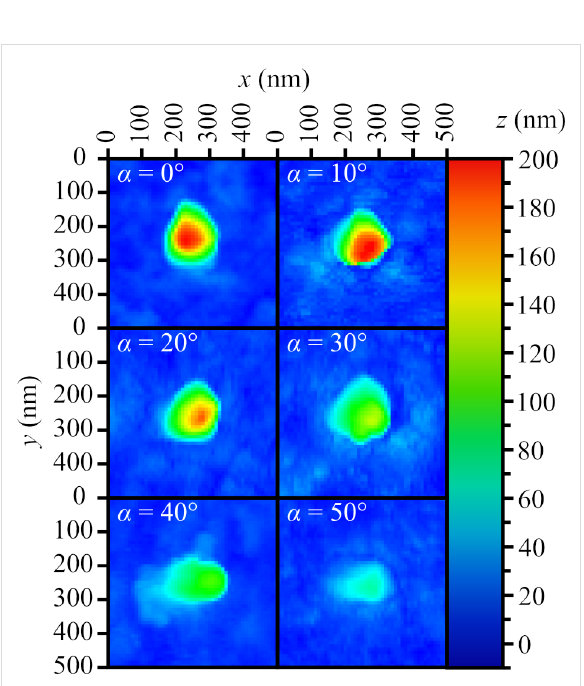
Figure 5: Atomic force microscopy images of the nanostructures on an Ag surface as a function of the angle of incidence of the electron beam. Constant EB parameters are: U = 30 kV, I = 42 pA, d = 14 nm, and t = 60 s. as the angle of incidence increased up to 50° (Figure 4). We ex- pected to observe a displacement of the peaks of the nanostruc- tures towards the direction of the EB as the angle of